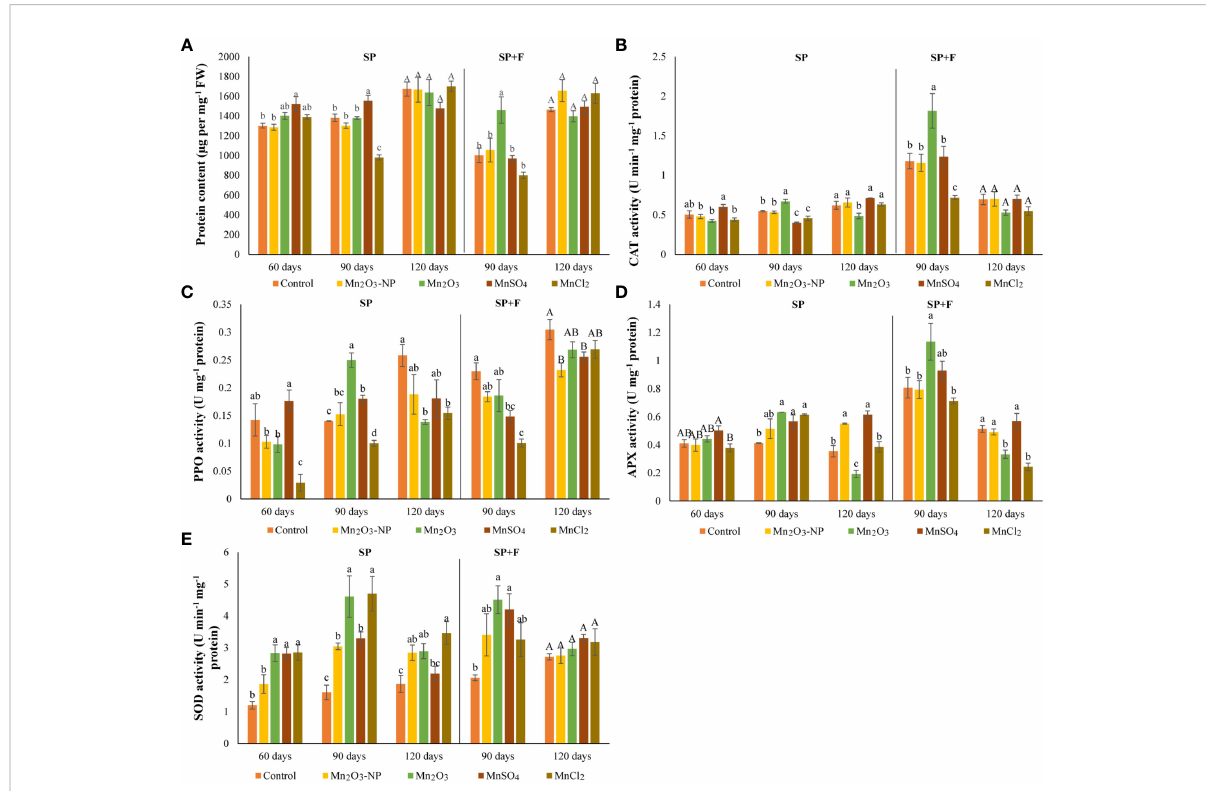
FIGURE 4 Protein content (A) and antioxidant enzymes (PPO (B) , APX (C) , SOD (D) , and CAT (E) ) of A. annua under different Mn treatments using SP and a combination of SP+F at different time